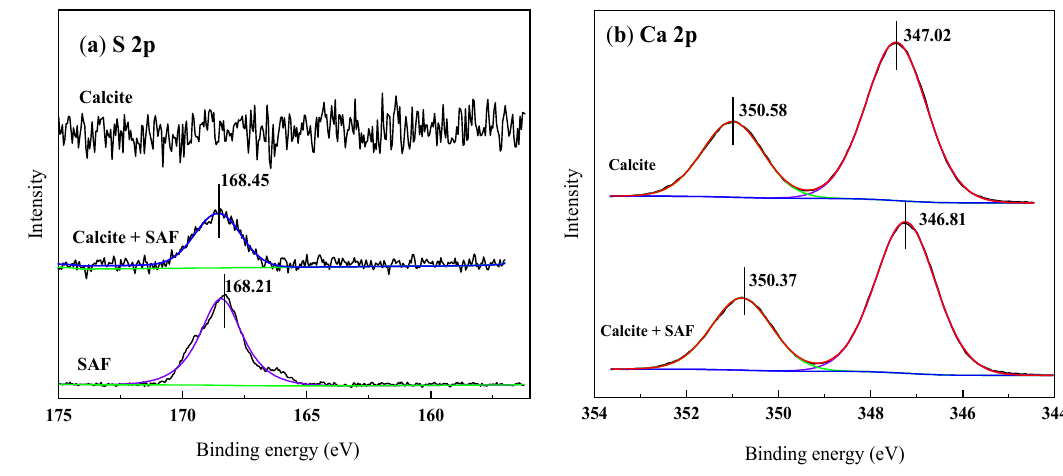
Figure 11. XPS of ( a ) S 2p and ( b ) Ca 2p signal of calcite treated with SAF and without SAF at pH 9.